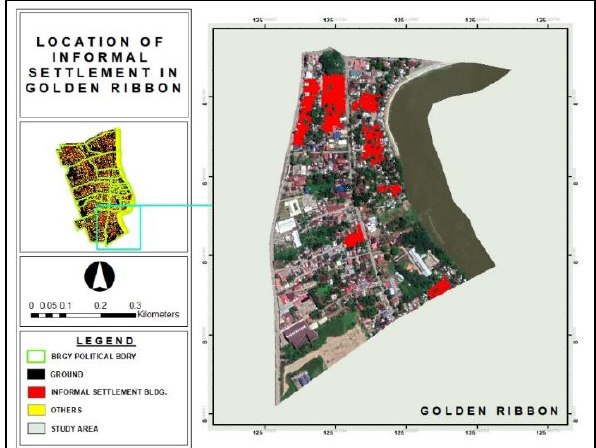
Figure 5. Informal Settlement in Brgy. Golden Ribbon